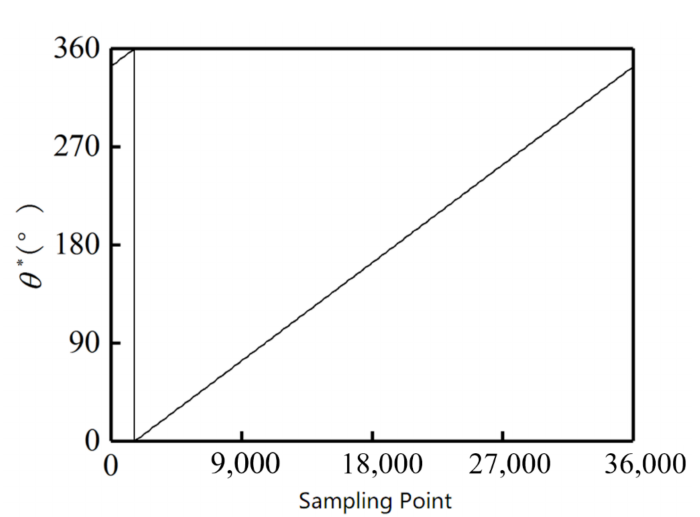
Figure 16. Decoding result.